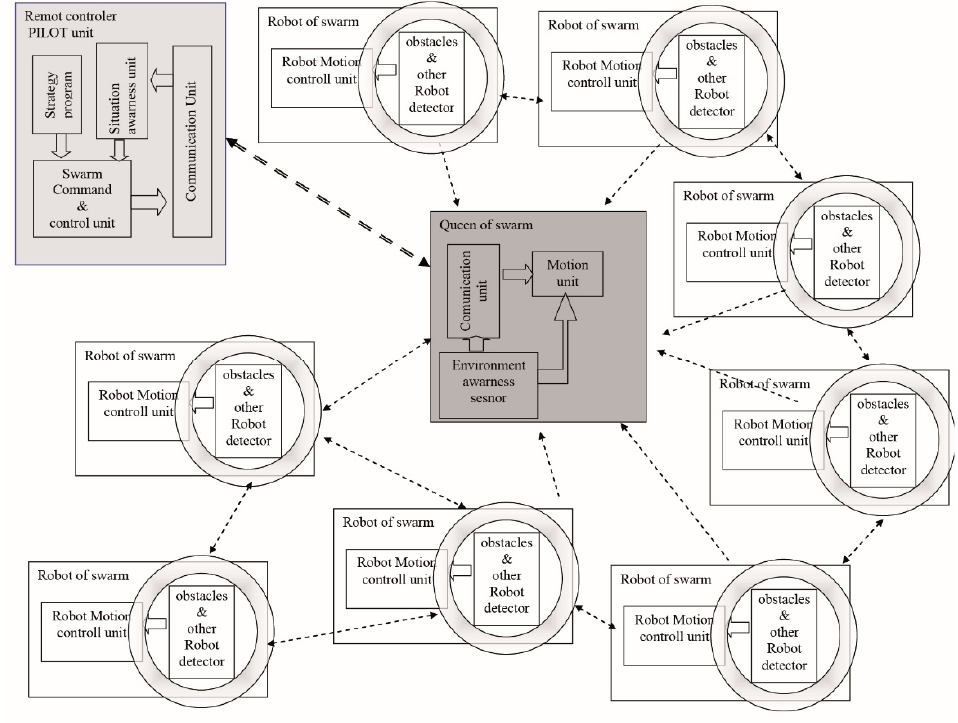
Figure 24. A bee-like robot